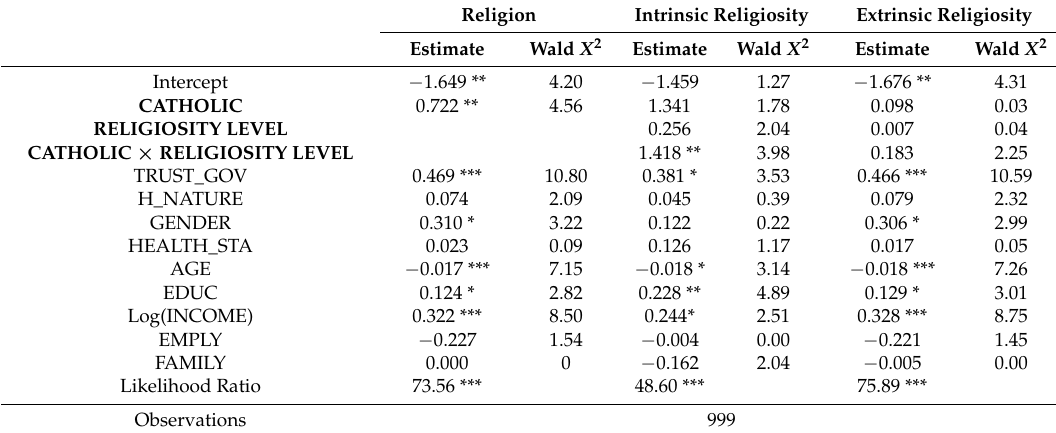
Table 8. The effect of Catholic and religiosity level on the willingness to donate